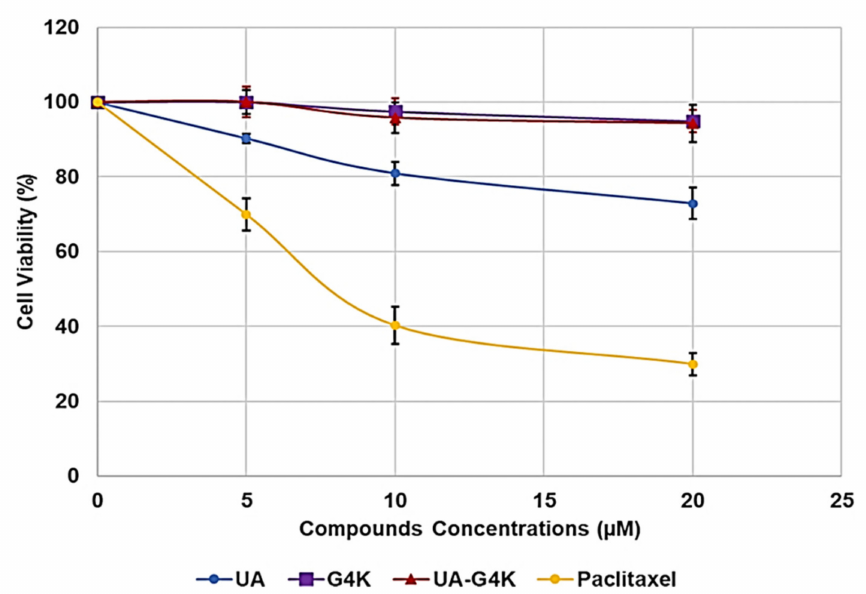
Figure 2. Cells viability of Hela cells exposed for 24 h to UA, G4K, UA-G4K and paclitaxel at concentration 5–20 µ